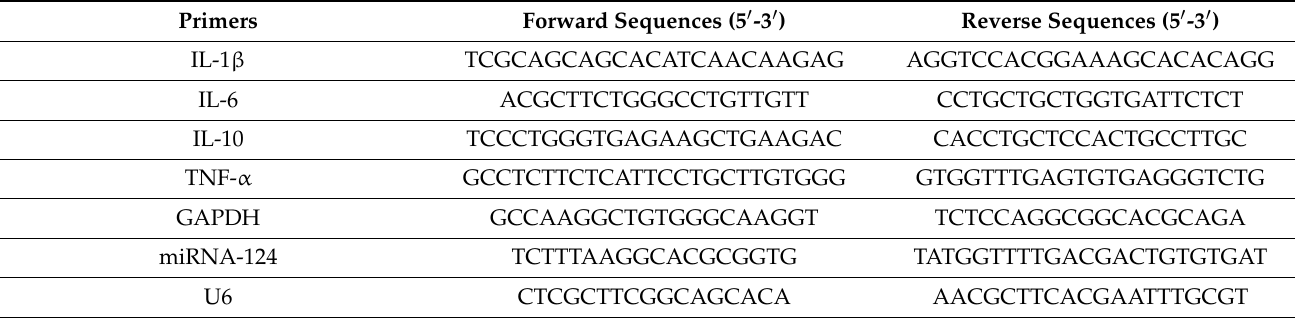
Table 1. Primer sequences of real-time